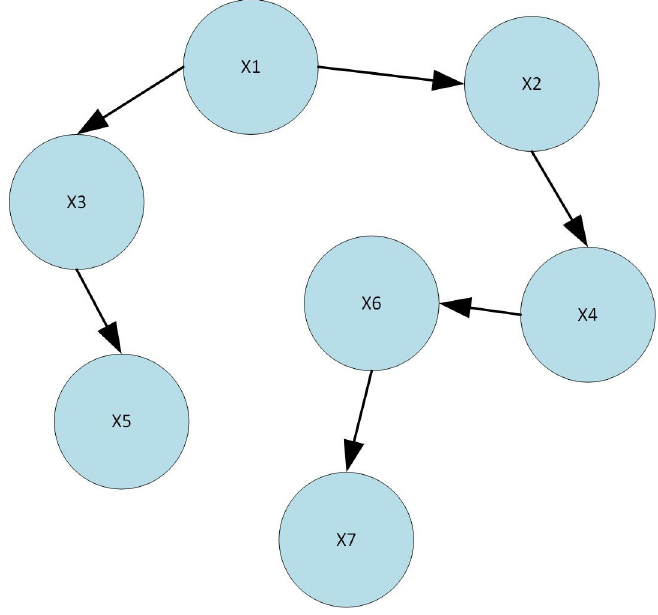
Figure 3. Control flow graph.